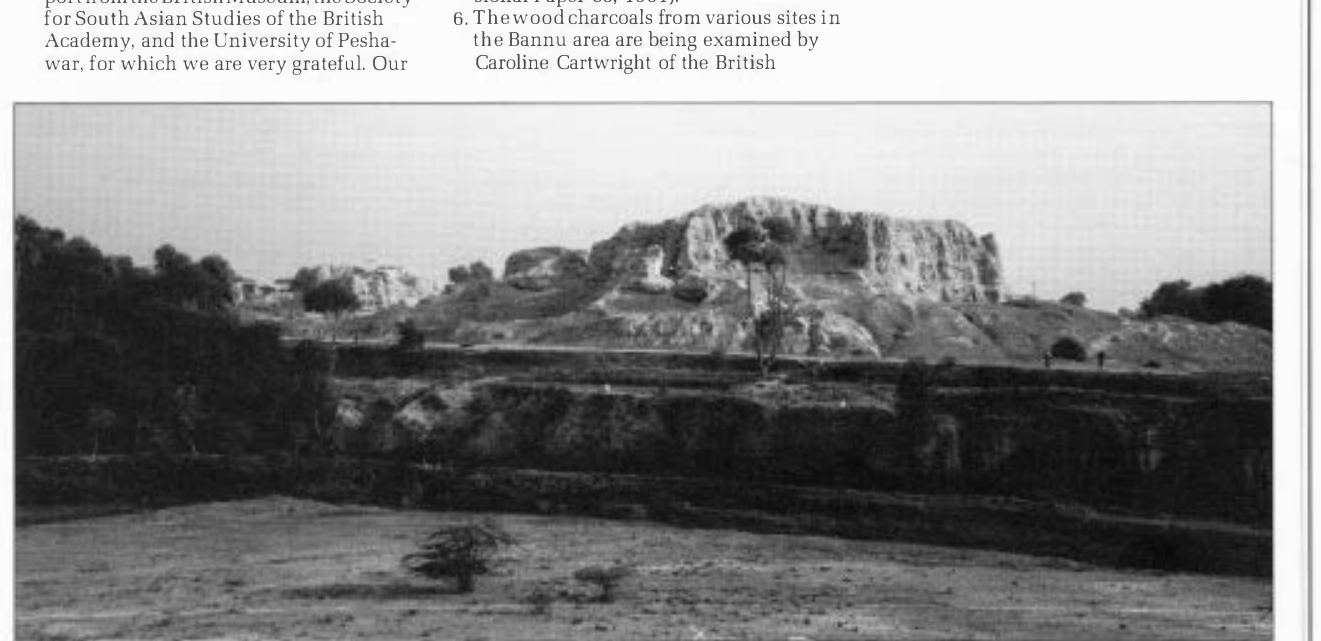
Figure 7 The main mound of Akra viewed from the west. The higher mound or "acropolis" is situated on a lower more extensive mound; together they rise to some 35 m above the surrounding plain, which is here cut by a stream that flows below the cliff-like feature in the